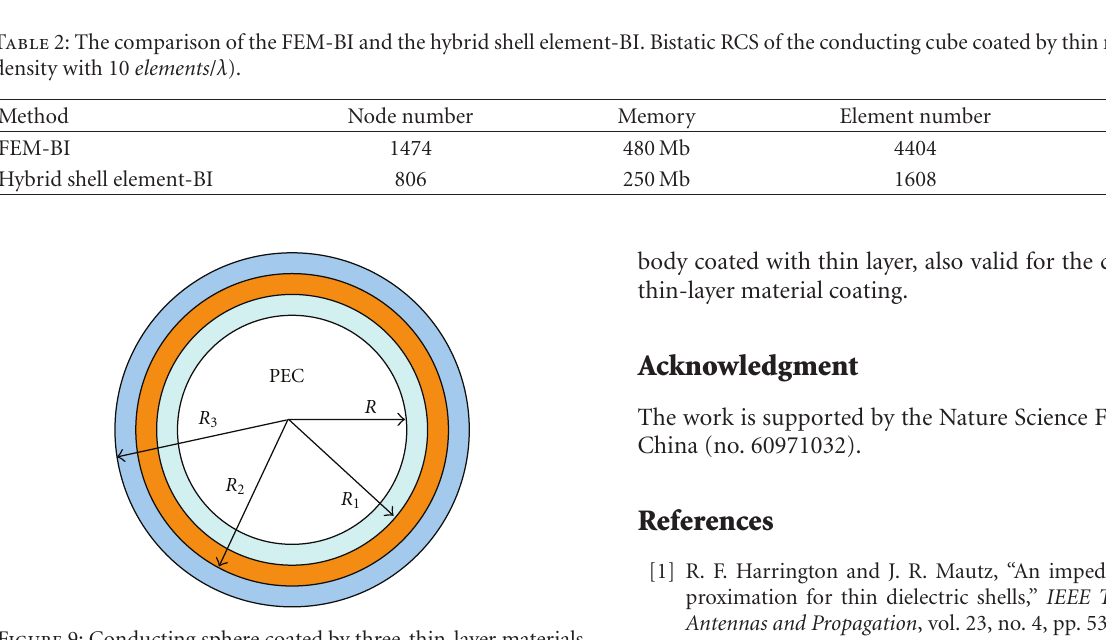
Figure 9: Conducting sphere coated by three-thin-layer materials.